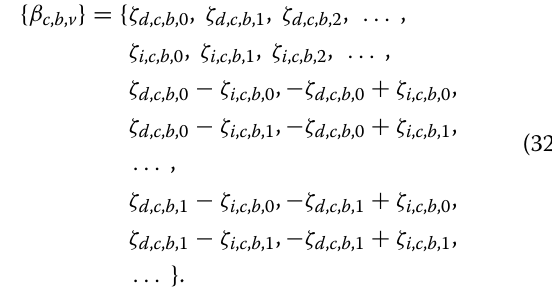
The set of FSs { β c , b , v } is formed using the set of CFs of the conjugate spectral correlation for the PMW, { ζ d , c , b , u } , and interference, { ζ i , c , b , v } , and their